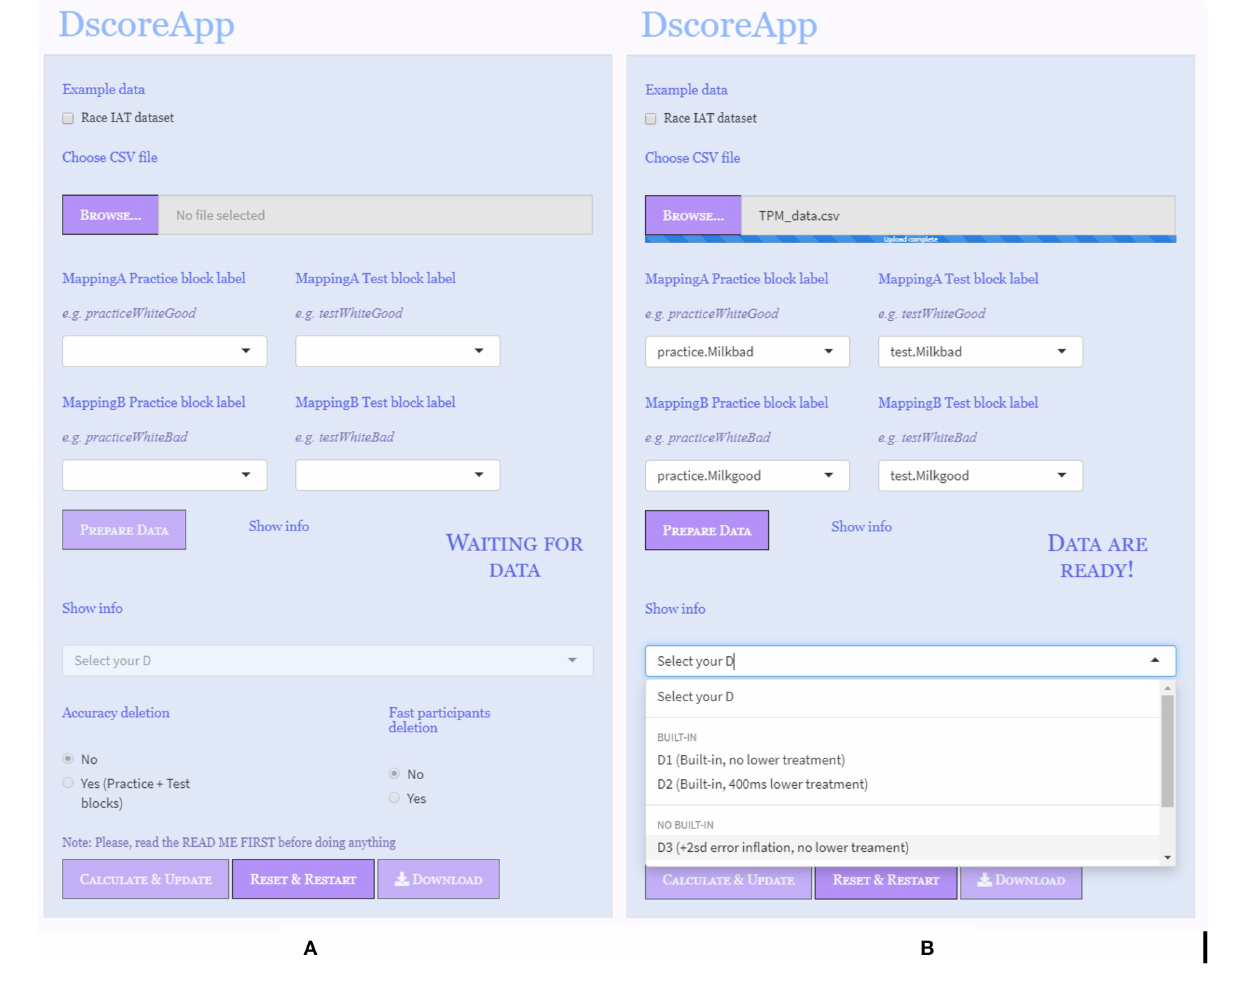
FIGURE 1 | Input panel. (A) Data correctly uploaded. (B) Data ready for